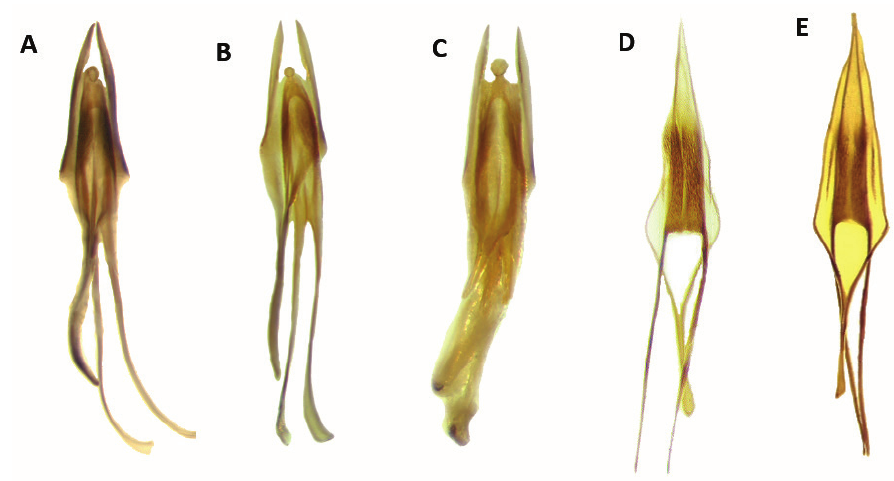
Figure 18. Male genitalia of: A Araeodontia isabellae B Araeodontia marginalis C Araeodontia peninsularis D Bogcia disjuncta E Bogcia oaxacae syn.